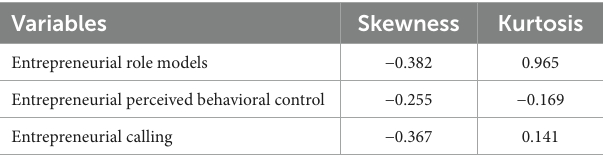
TABLE 4 Skewness and kurtosis of each variable. Variables